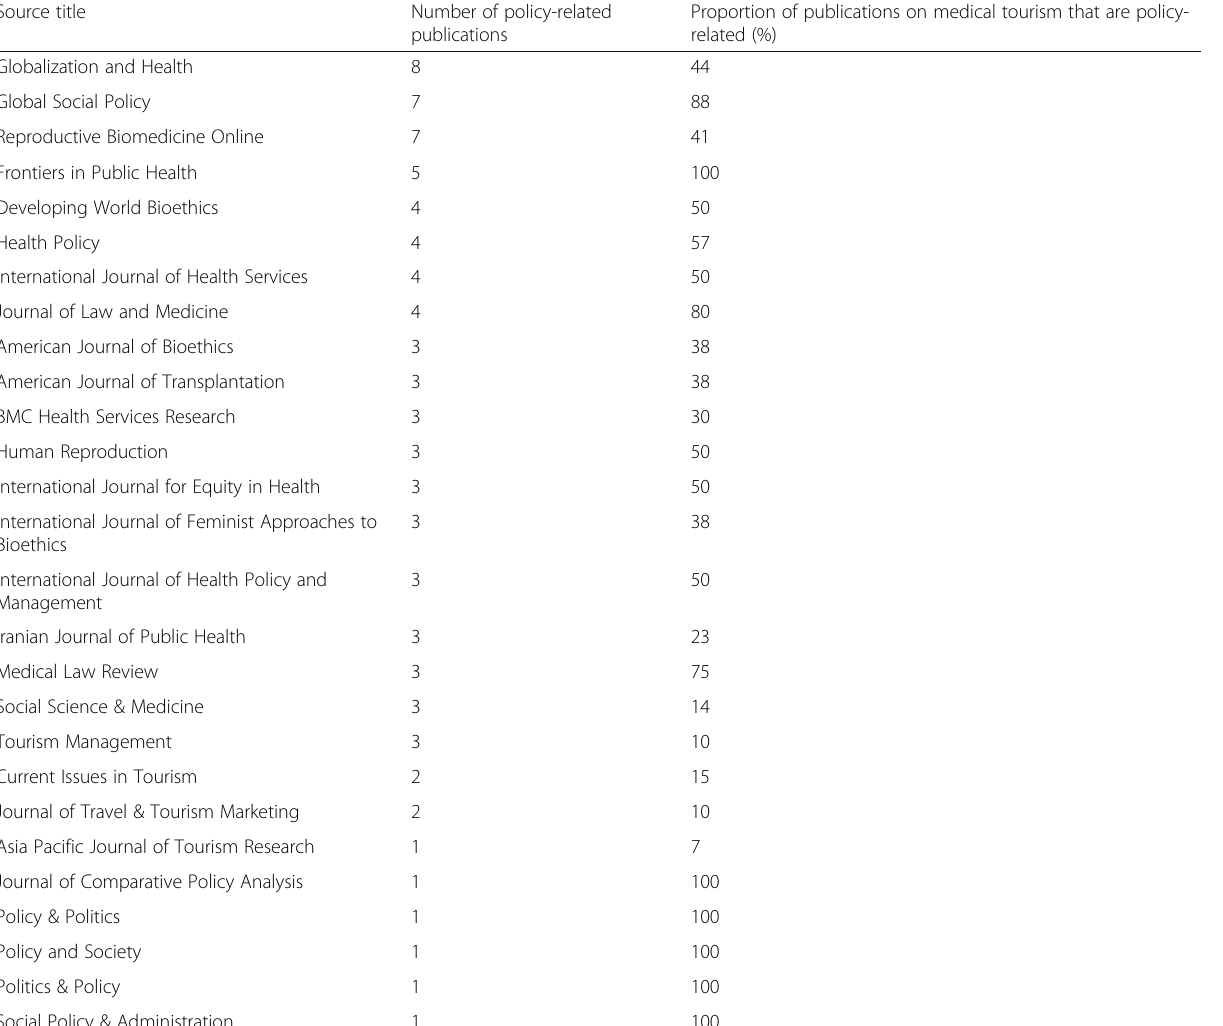
Table 3 Policy-related publications on medical tourism in various journals (selected list) Source title Number of policy-related Proportion of publications on medical tourism that are policy- publications related